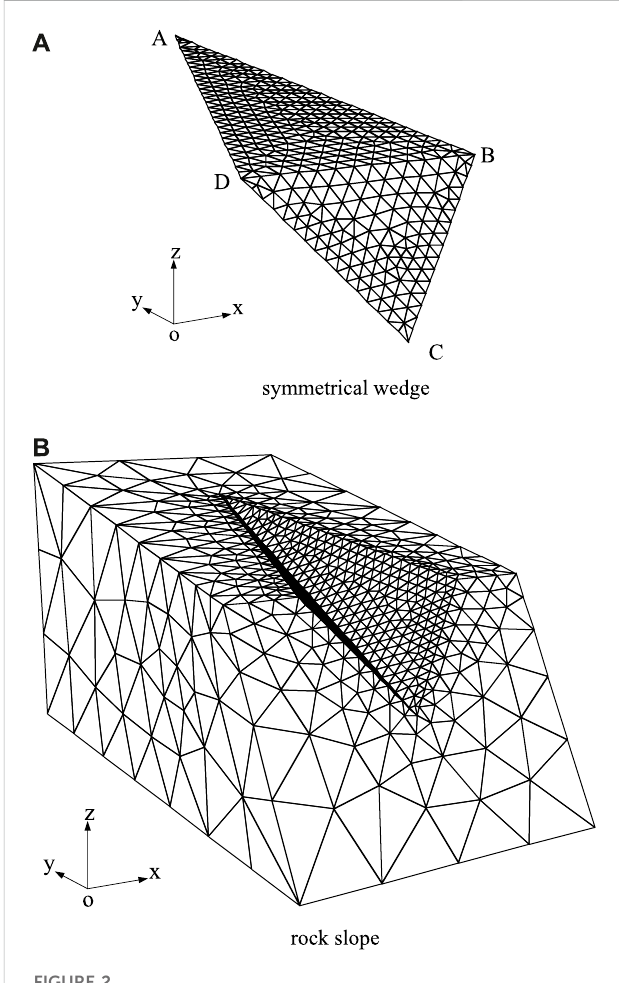
FIGURE 2 Three-dimensional mesh discretization for rock slopes with a symmetrical wedge. (A) Symmetrical wedge (B) Rock